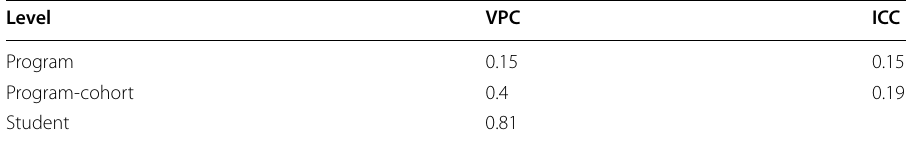
Table 4 VPC and ICC statistics for the three-level variance components model (null-model) for students’